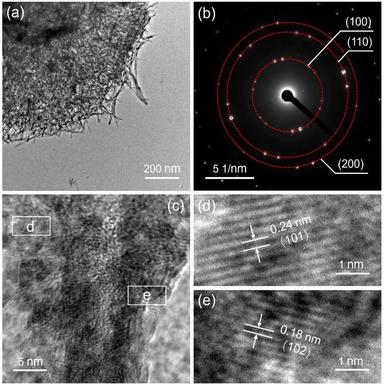
(a) TEM image of β-type Co(OH)2 microclews, and (b) the corresponding SAED pattern as well as (c-e) HRTEM images of beta-phase Co(OH)2 microclews.